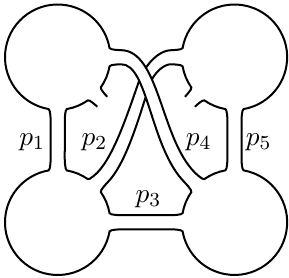
Figure 12. The Feynman graph in (cid:12)gure 11 can be used to construct a Riemann surface with pinching parameters arranged in such a way that the graph is recovered in the (cid:11) 0 ! 0 limit, after matching pinching parameters to Schwinger parameters according to eq.